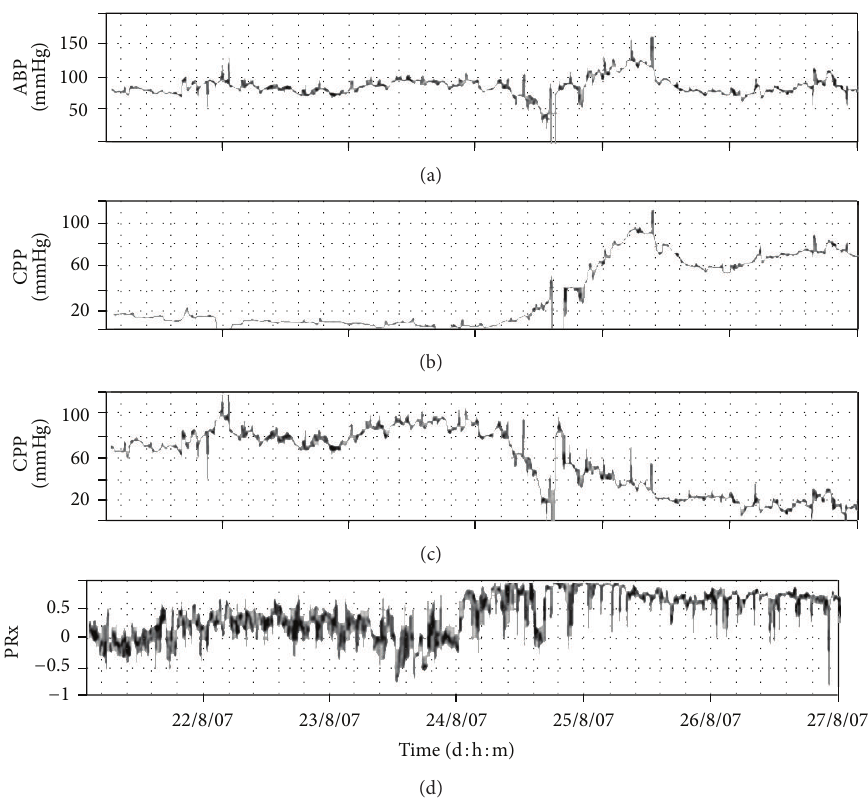
Figure 5: Increase in ICP above 20 and then above 80mmHg. PRx in this case deteriorates almost half of a day before. ICP: intracranial pressure. ABP: arterial blood pressure. CPP: cerebral perfusion pressure. PRx: pressure reactivity index.